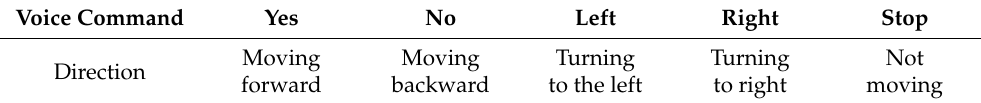
Figure 1. Overall system architecture. Table 1. File of voice